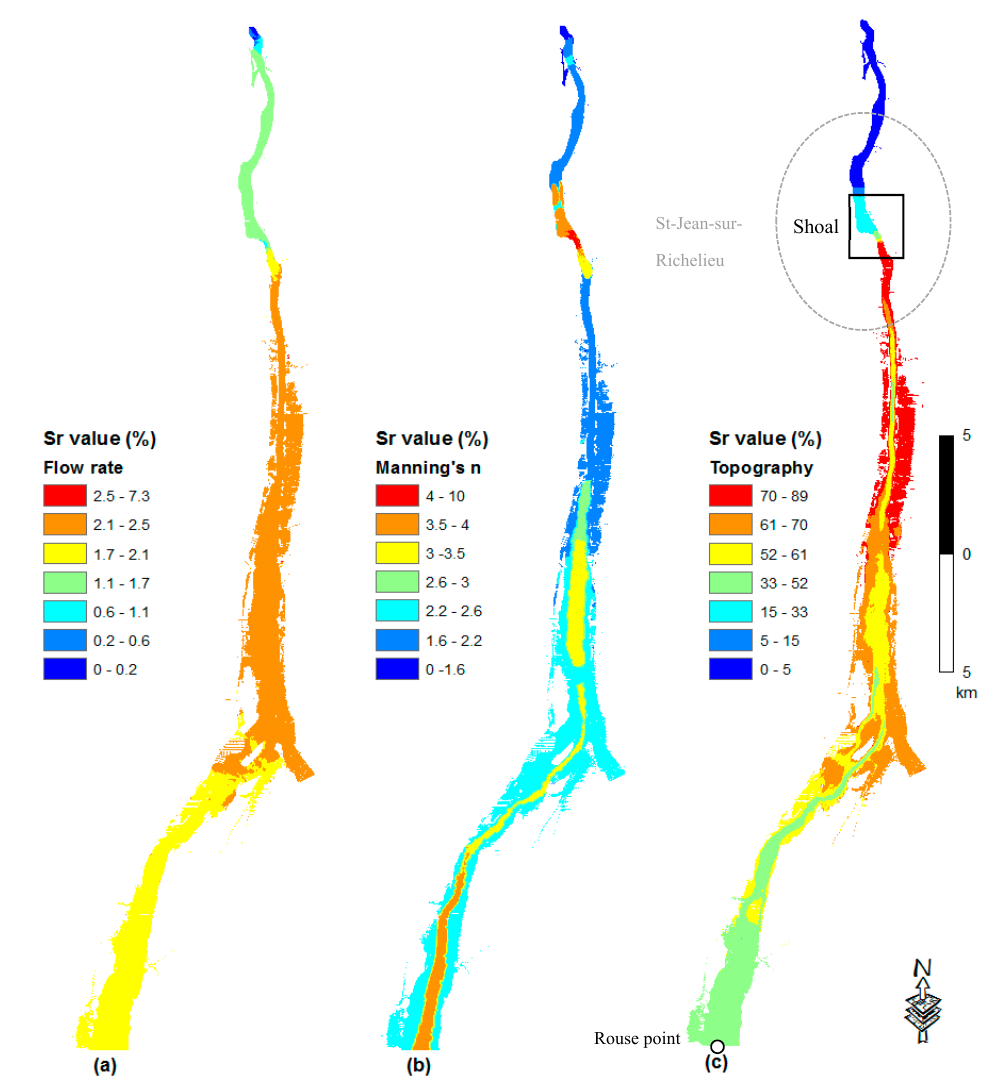
Figure 6. Sensitivity of the simulated flow depths to each of the three input variables, ( a ) flow rate, ( b ) Manning’s coe ffi cient Sr ( X 2 ) , and ( c ) topography Sr ( X 3 ) , for nominal flow rate of 824 m 3